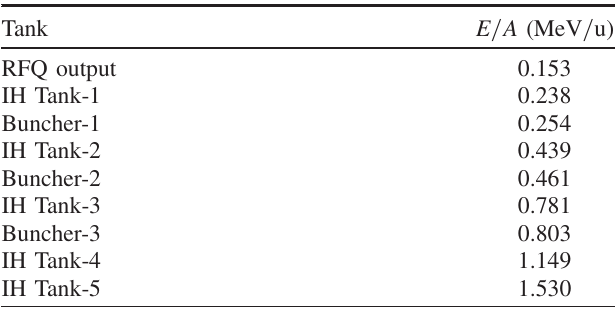
TABLE I. Typical operational energy configuration of the